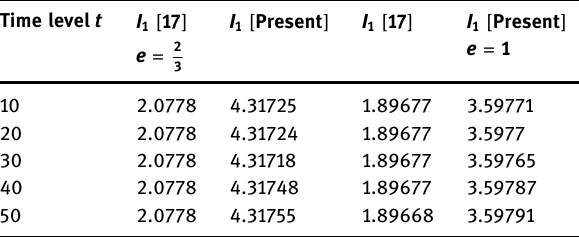
Table 7: Comparison of conserved quantity for interaction of three solitons for = t Δ 0.01 , = N 301 , = δ 0.5 ,